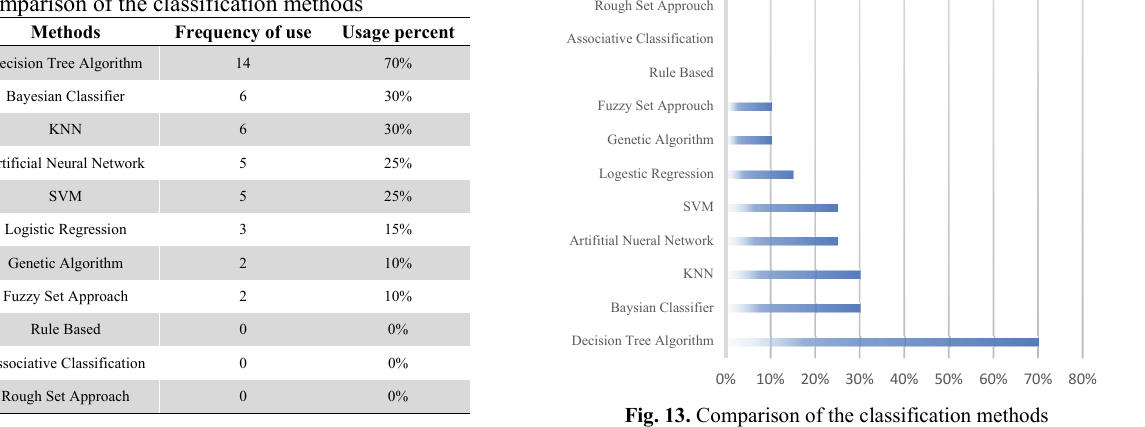
The overall review of the classification methods